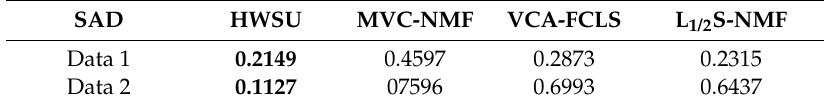
Table 4. The SAD of unmixing results using HWSU, VCA-FCLS, MVC-NMF, L 1/2 S-NMF. SAD